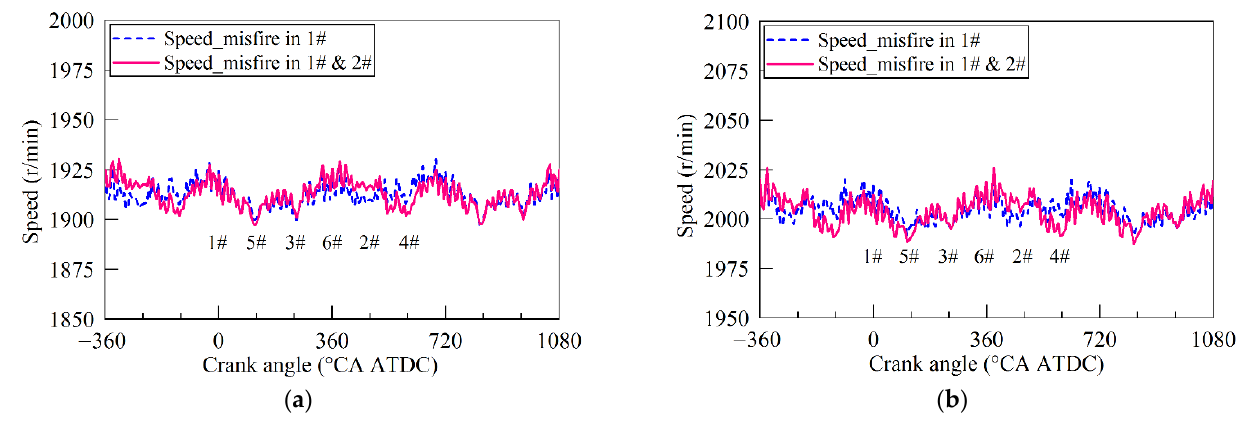
Figure 4. Instantaneous engine speed comparison between cylinder 1# misfire and cylinders 1# and 2# misfire conditions. ( a ) Under 1900 r/min and 100 Nm. ( b ) Under 2000 r/min and no-load condition.